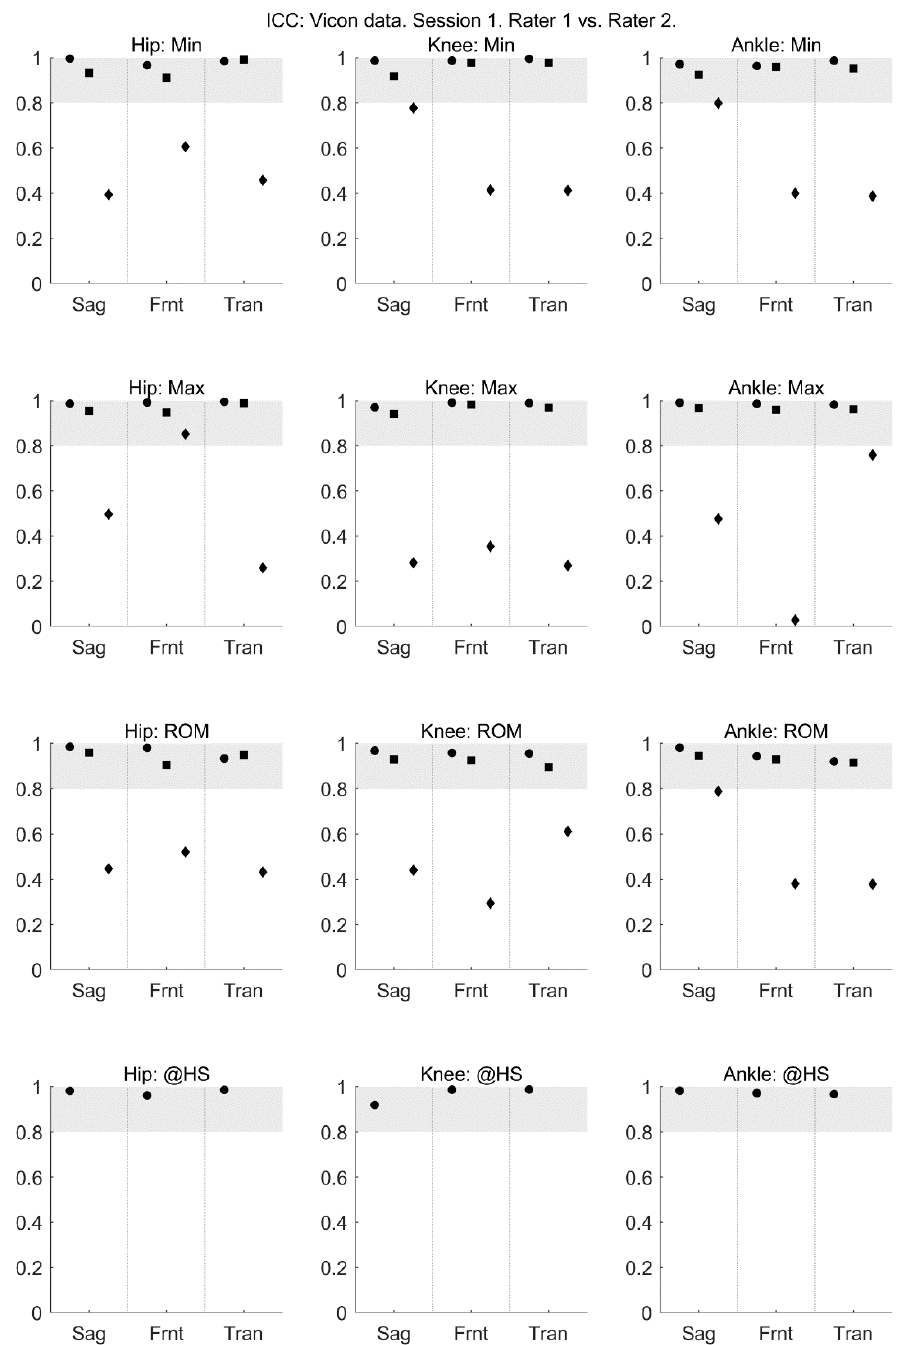
Figure A1. Within-session intraclass correlation coefficient of VICON data collected in session 1. Intraclass correlation coefficient is shown for the minimum angle (min; top row ), maximum angle (max; second row ), range of motion (ROM; third row ) and angle at heel strike (@HS; bottom row ) for the hip (left-most column), knee (centre column) and ankle (right-most column) joints in the sagittal (Sag), frontal (Frnt) and transverse (Tran) planes of movement. The three data points in each plane correspond to the walk (left-most point; circle), squat (centre point; square) and jump (right-most point; diamond) tasks. Grey shading indicates values considered to indicate excellent reliability.